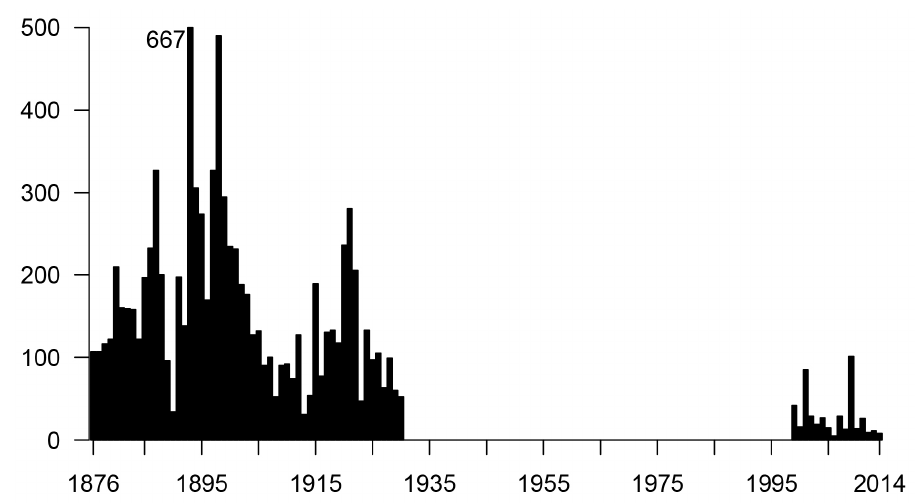
Figure 10. Illustration of the total number of livestock depredated by carnivores per year, 1876–1930 and 1998–2014, in the county of Jämtland. Sources: Swedish National Forest Service and the Wildlife Damage Centre. Please note that there are no records of livestock killed for the years 1931 to 1998.